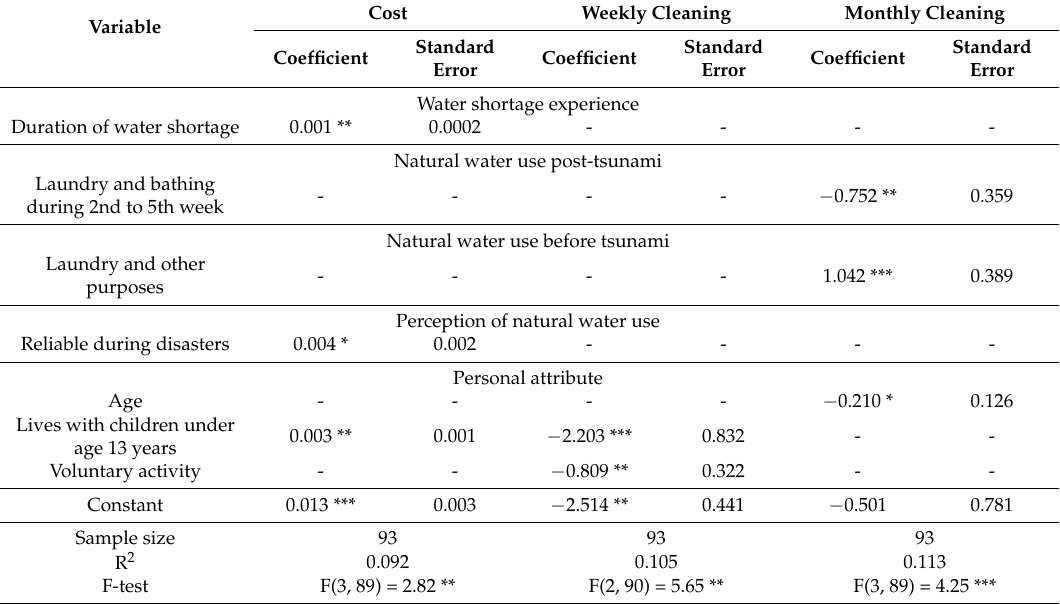
Table 7. Regression of individual parameters on explanatory variables (cost and cleaning